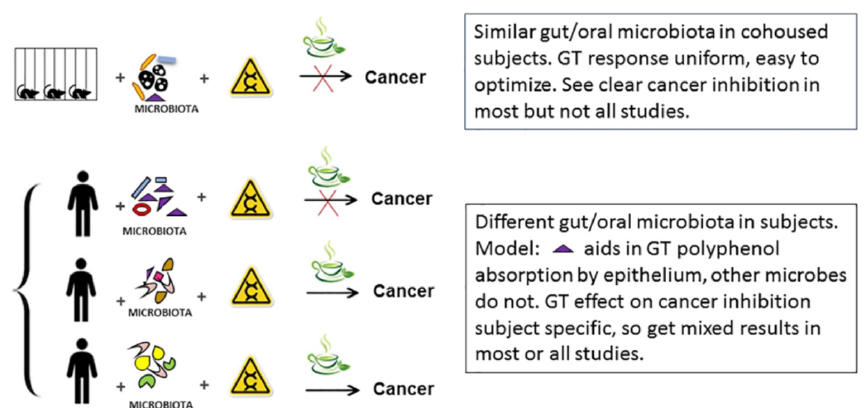
Figure 2. Model of shared oral/gut microbiota on ability of GT and GT polyphenols to prevent cancer. represents a bacterium that is efficient at converting GT polyphenols to bioactive forms readily absorbed by digestive tract epithelial cells. The human with high levels of this bacterium would readily process GT catechins to active, absorbed forms, and show a response. The other two humans who lack this bacterium would not.